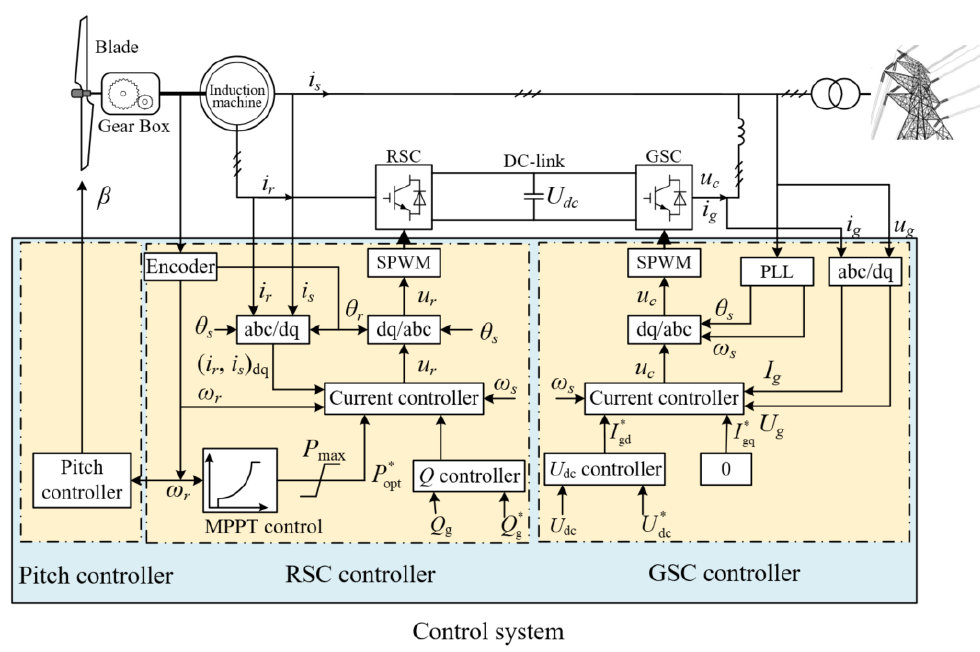
Figure 2. Typical configuration of a DFIG.